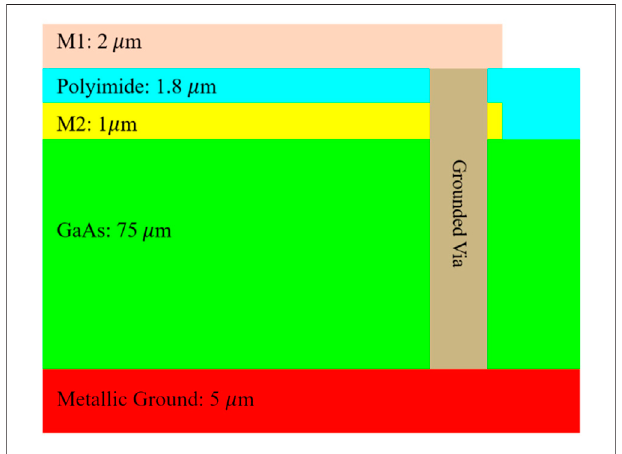
FIGURE 1 | Stack-up of the employed 0.15- μ m GaAs pHEMT technology.